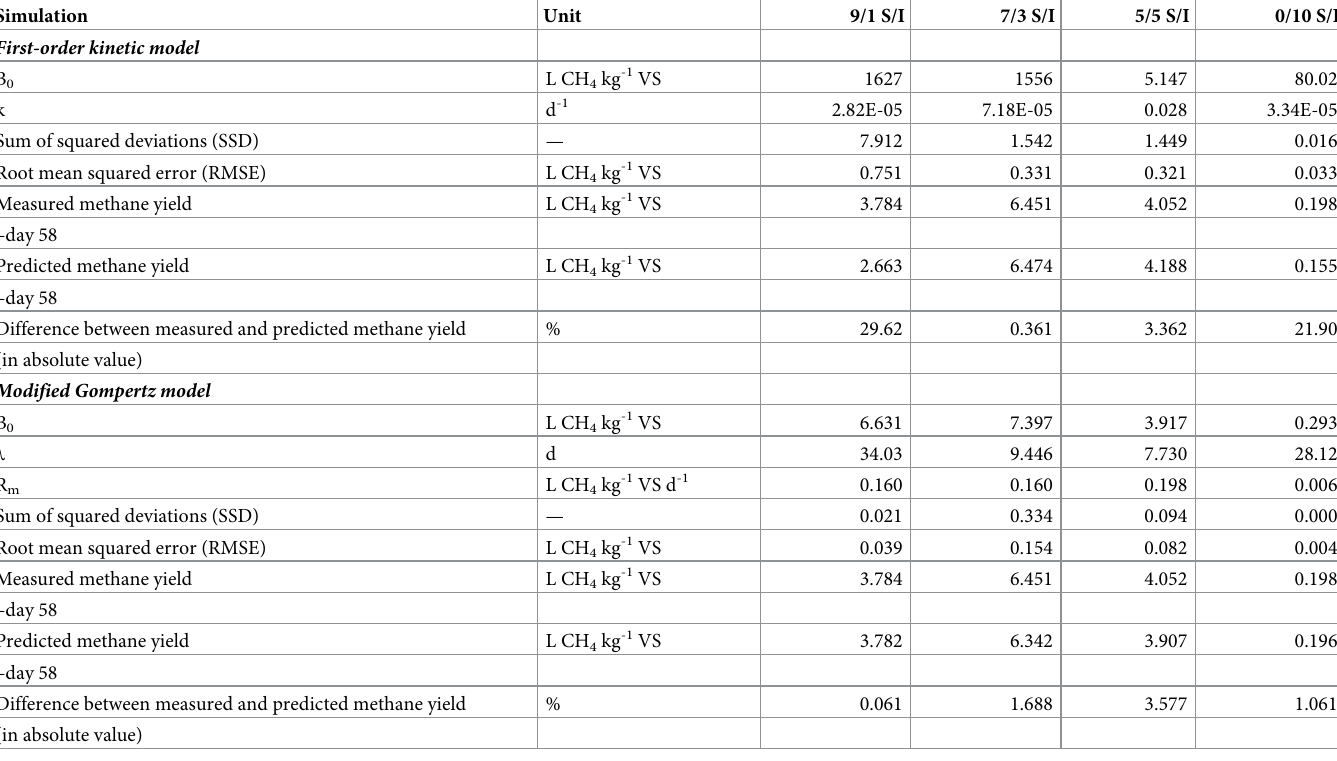
Table 4. Parameters and goodness fit obtained with the evaluated models, first-order kinetic and the modified Gompertz, for the waste treatment over 58 days at 45˚C. Simulation